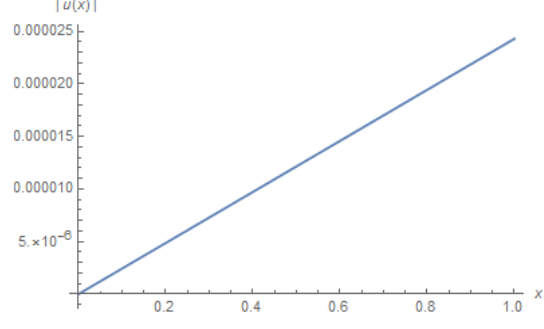
Figure 3:3D Solutions of example3 with di⁄erent values of (cid:11)